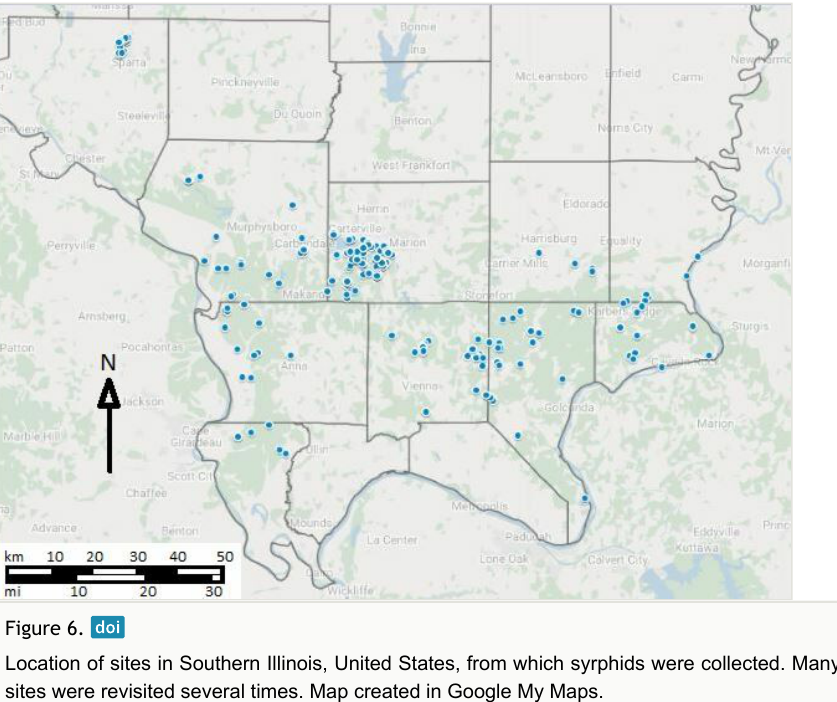
Figure 6. Location of sites in Southern Illinois, United States, from which syrphids were collected. Many sites were revisited several times. Map created in Google My To test for significant differences in pollen load size between species, a weighted mean score for each specimen was calculated by downweighting the scores for the three head regions by 1/3, and then averaging all 8 scores. Downweighting the head regions corrected the bias of having three head regions versus two abdominal and thoracic regions. These weighted mean scores were used to run a Kruskal-Wallis non-parametric test and post-hoc Bonferroni corrected pairwise Wilcoxon Rank Sum Tests in R (alpha=.05). Only those